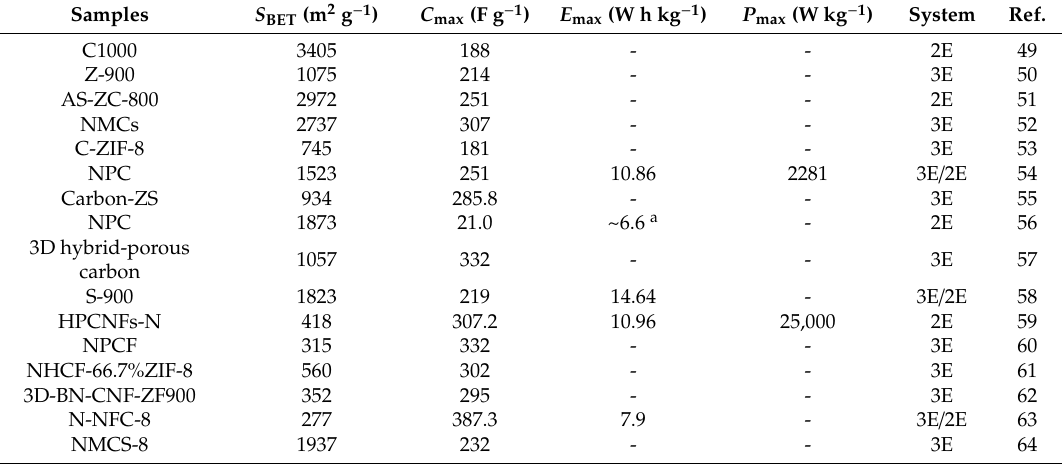
Table 2. The electrochemical capacitive performances of porous carbons derived from ZIF-8.